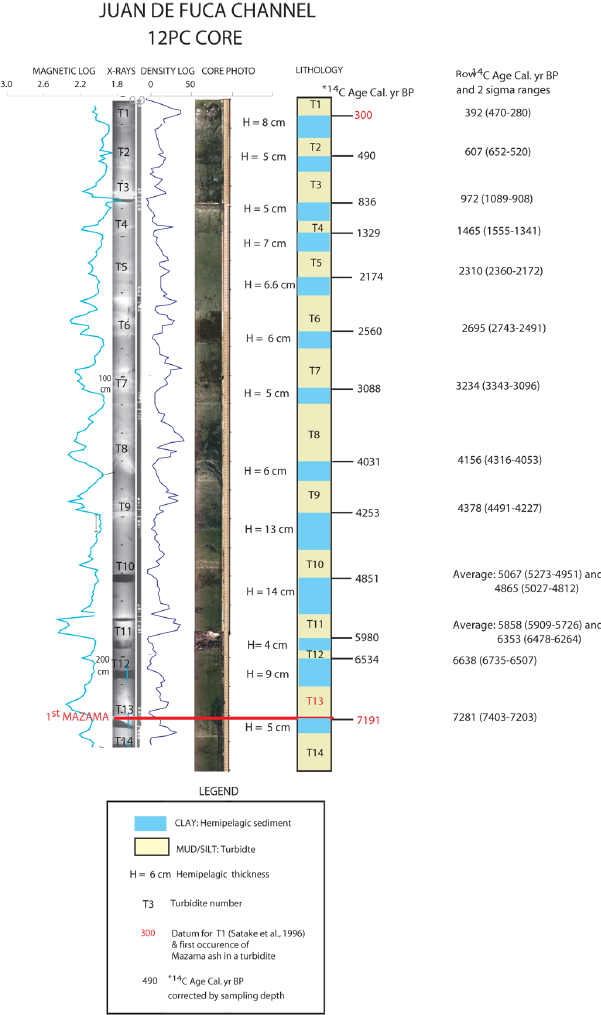
Fig. 4. Juan de Fuca Channel 12PC core showing lithology, pho- tographs, and magnetic and density log signatures in light and dark blue, respectively. Note most turbidites have multiple coarse- grained sediment pulses in turbidites as exhibited by high density and magnetic peaks and lighter intervals in X-ray radiographs. Note that there is no hemipelagic sediment between pulses of the indi- vidual turbidites and that no mass transport deposits are evident as chaotic debris in the radiographs. The first occurrence of Mazama ash at T13, the main regional datum, is keyed in red. See Fig. 5 also for a detailed analysis of correlative turbidite